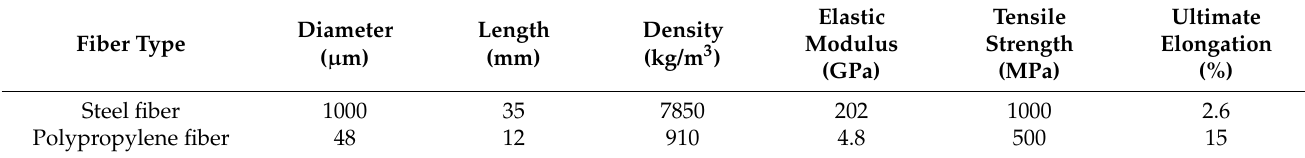
Table 2. Fiber performance index.